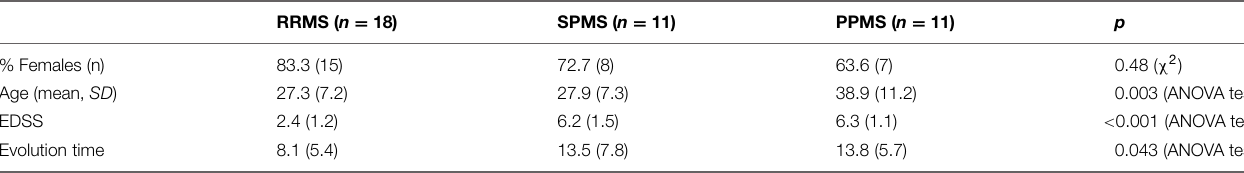
TABLE 4 | Characteristics of MS patients according to the clinical classification.